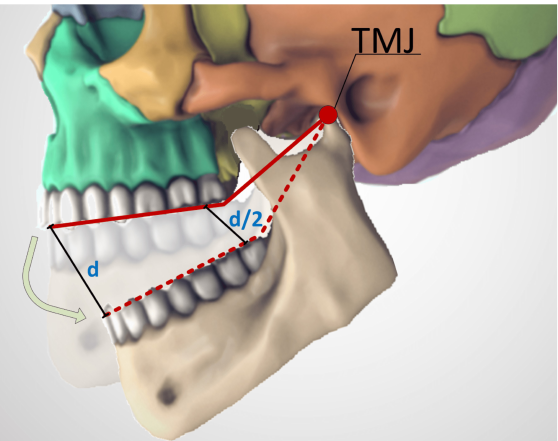
Figure 15. Path difference for sensors mounted at different distances from the temporomandibular joint. For a system with limited dynamic range, a shorter path would allow to record wider jaw movements. Adapted from